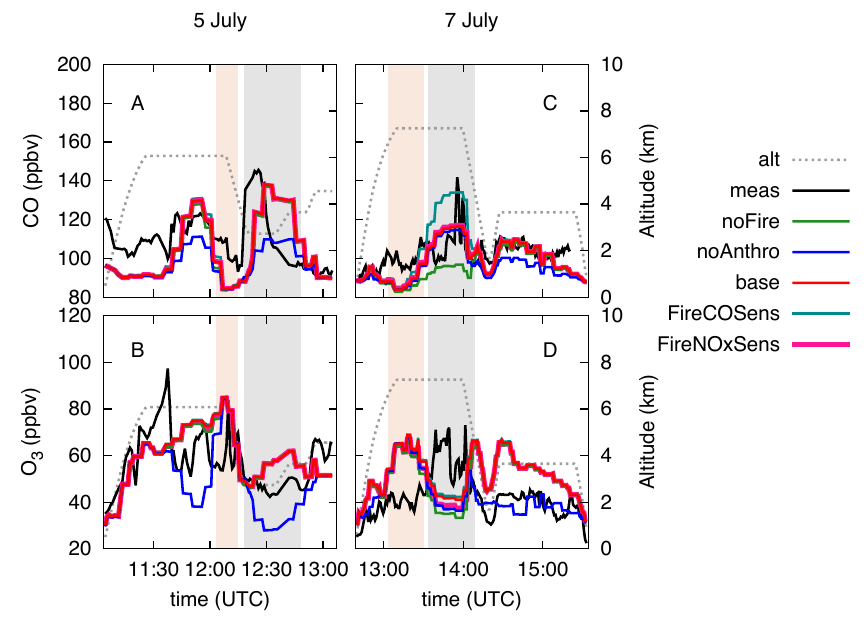
Fig. 8. Comparison of WRF-Chem results with measurements made onboard the ATR-42 aircraft on 5 and 7 July. Measurements are in black, the model base run is in red, the noFire run is in green, the noAnthro run is in blue, and the FireCOSens run is in teal. The dashed line represents the aircraft altitude. The plumes investigated in more detail are highlighted using the gray background. High ozone air masses in the model are highlighted using the tan background. See text for details.